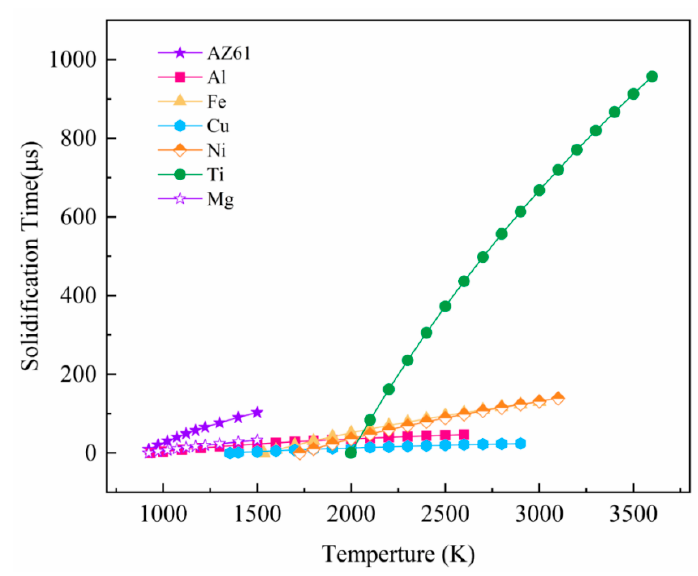
Figure 9. Comparison of different metal melt solidification processes.